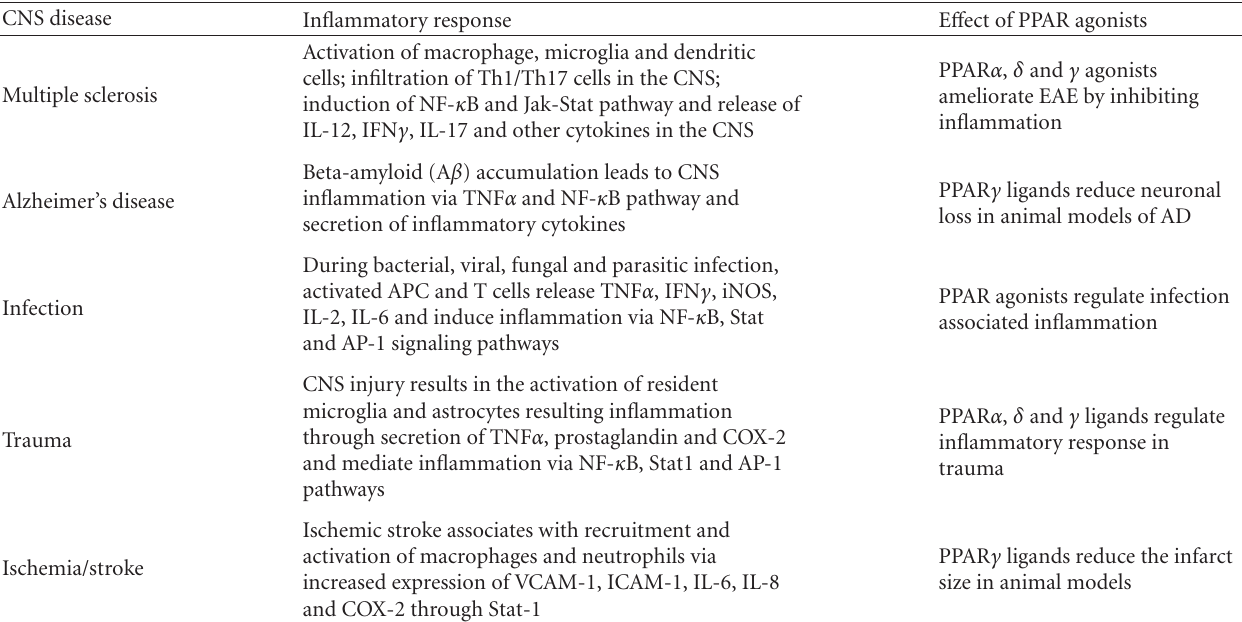
Table 1: Role of PPARs in the regulation of neuroinflammatory